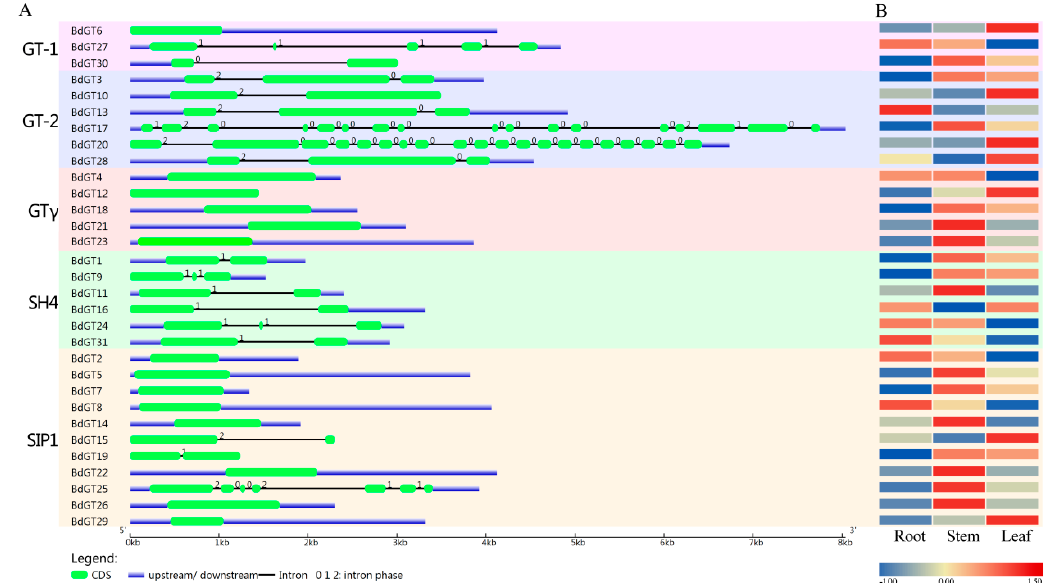
Figure 2. Gene structure and tissue-specific expression heatmap of BdGTs . ( A ) Exon-intron organization of corresponding BdGT gene. The exons and introns are represented by boxes and lines, respectively. ( B ) Analysis of the GT genes in di ff erent tissues of B. distachyon . Heatmap representation and hierarchical clustering of SIP1, SH4, GT γ , GT-1, and GT-2 genes in root, stem, and